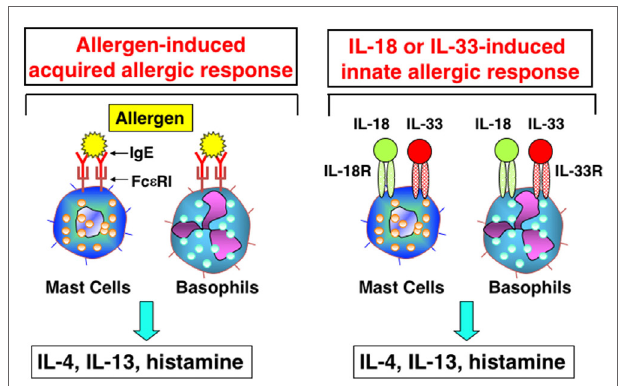
FigURe 3 | Interleukin (IL)-18 and IL-33 induce innate allergic response by stimulation of mast cells and basophils. Like mast cells or basophils stimulated with Ag/IgE complex, mast cells and basophils, expressing IL-18R and IL-33R, produce IL-4, IL-13 and chemical mediators, after being stimulated with IL-18 and IL-33,